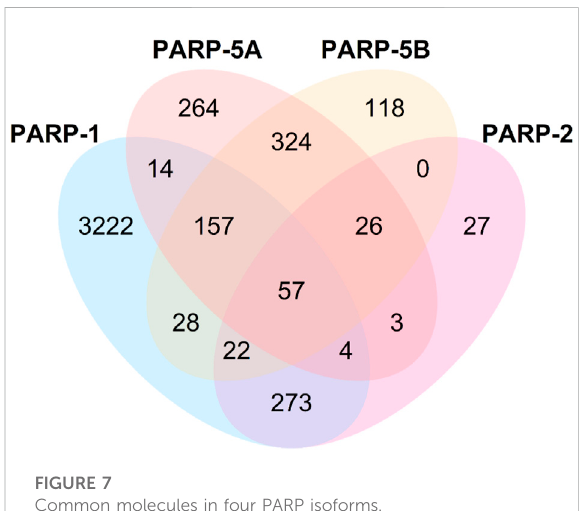
FIGURE 7 Common molecules in four PARP isoforms.